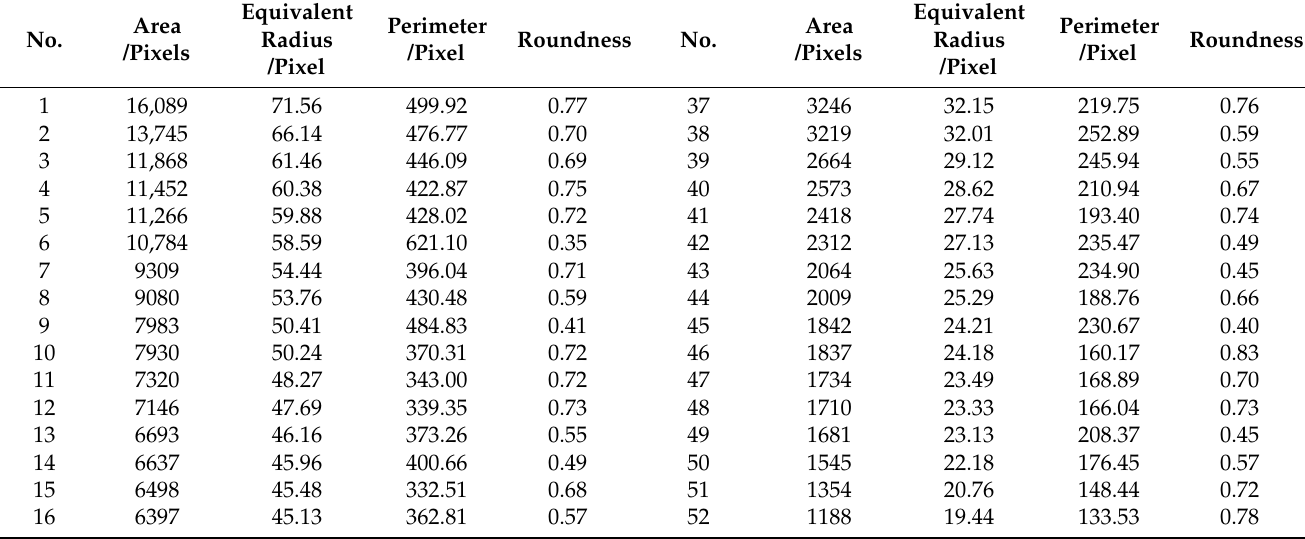
Figure 1. The process for obtaining grain boundaries (membranes) of porous sandstone. ( a ) Porous sandstone; ( b ) Grain separation; ( c ) Grain boundaries. Table 1. Grain geometry parameters (sorted by area from large to small).